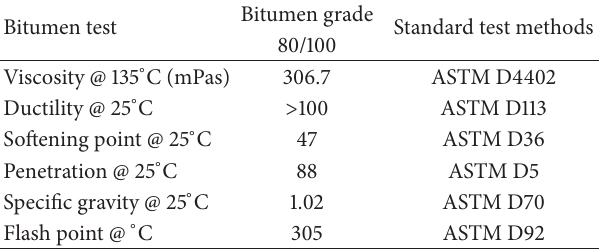
Table 5: Stability results (kN) for different CRM contents.